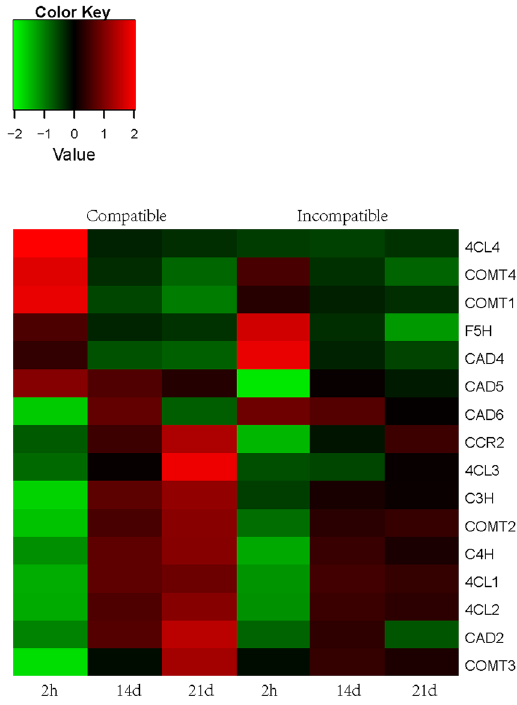
Figure 8. Heat map diagram of DEGs related to lignin biosynthesis in compatible and incompatible combination. Red color indicates a relative increase in expression, and green color represents a relative decrease in